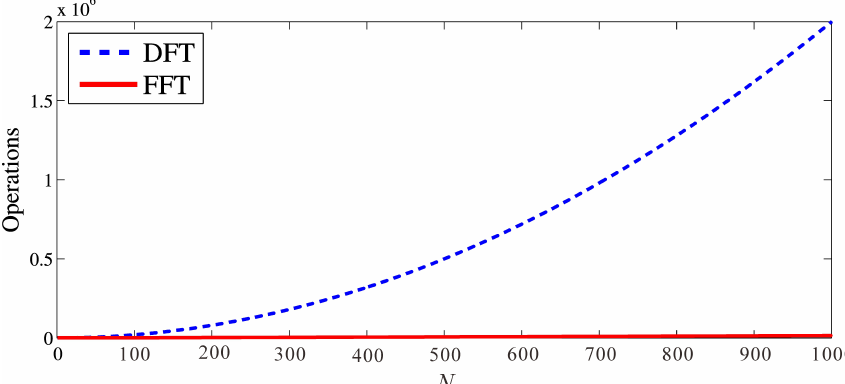
Figure 2. Relationships between computation amount and calculation points for discrete Fourier transform (DFT) and fast Fourier transform (FFT)